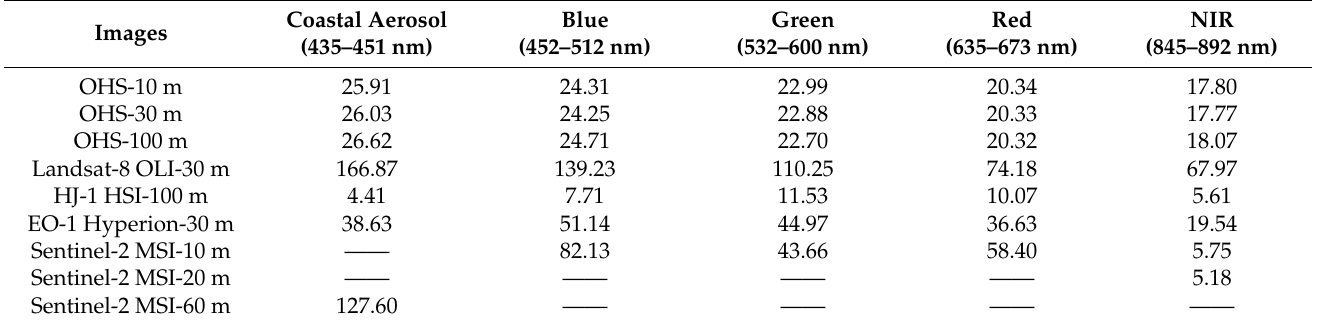
Table 4. Comparison of the SNR of OHS image, Landsat-8 OLI image, HJ-1 HSI image, EO-1 Hyperion image, and Senti- nel-2 MSI image for typical bands.